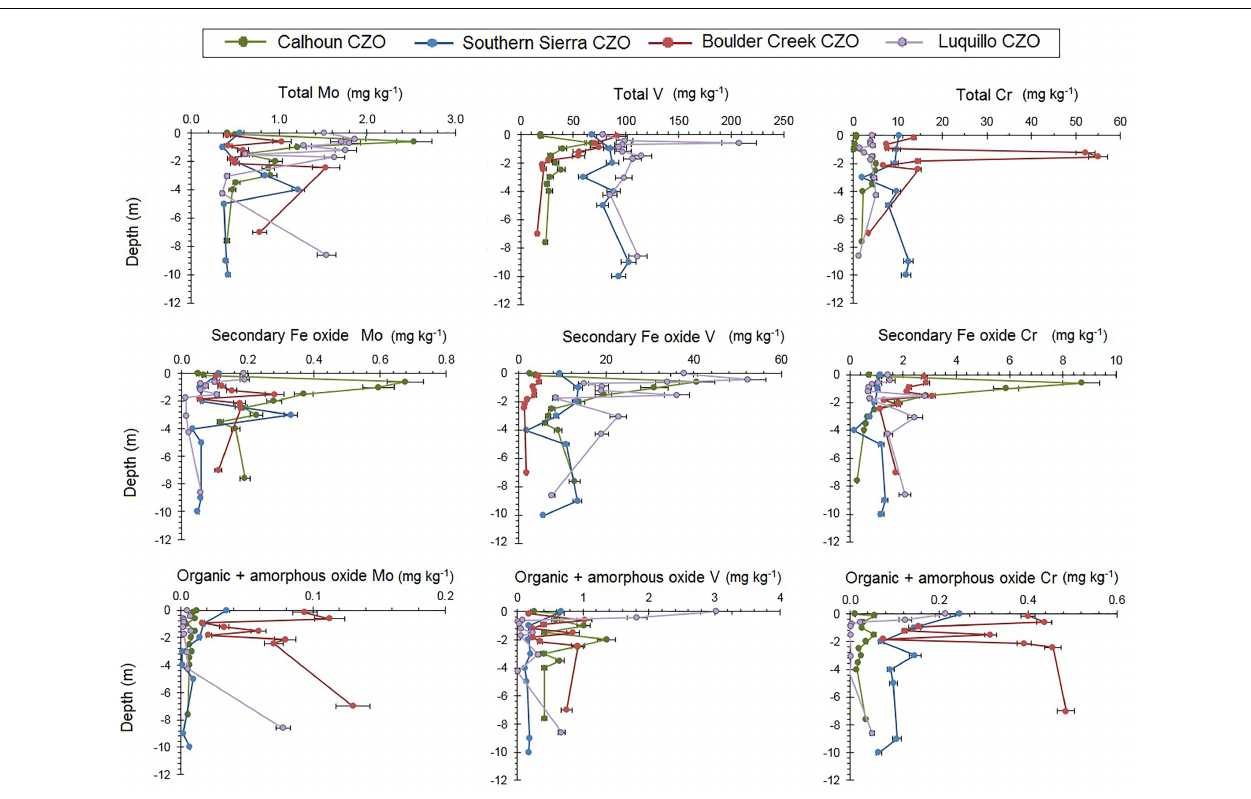
FIGURE 3 | Regolith profiles of TOC, total Fe, and secondary oxide Fe concentrations in total digests and secondary oxide extractions (citrate–bicarbonate–dithionate) at four CZOs. Note the different logarithmic scales for X -axes. Error bars are coefficients of variation.